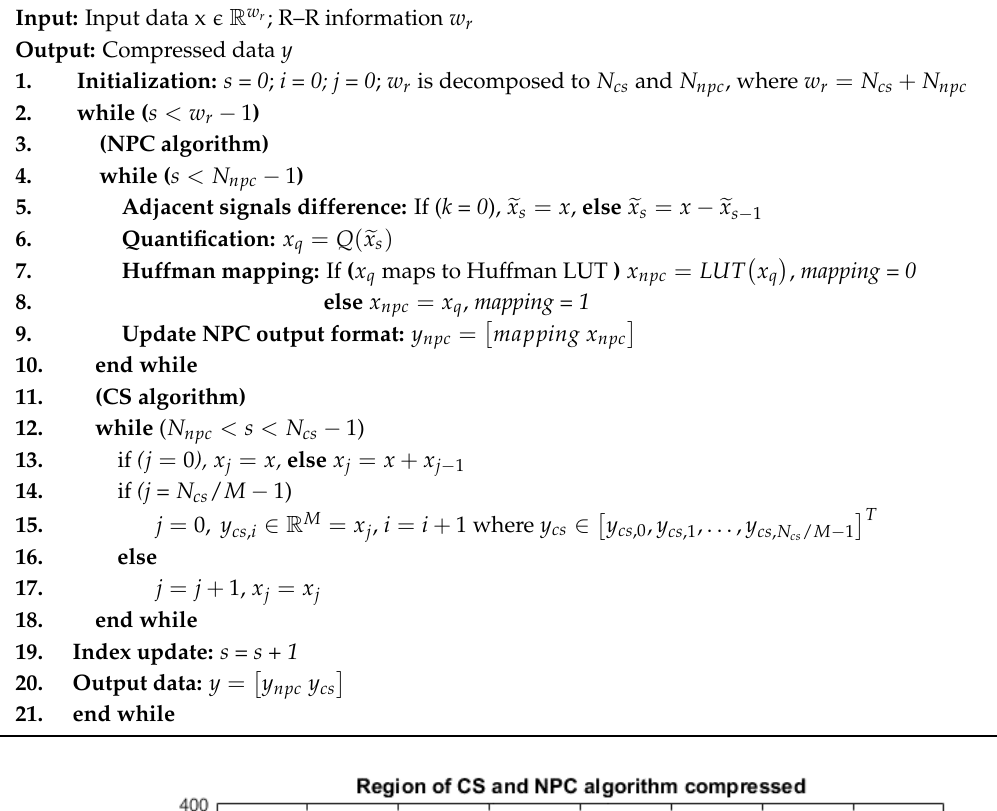
Algorithm 1. Proposed Adaptive Compressed Algorithm.